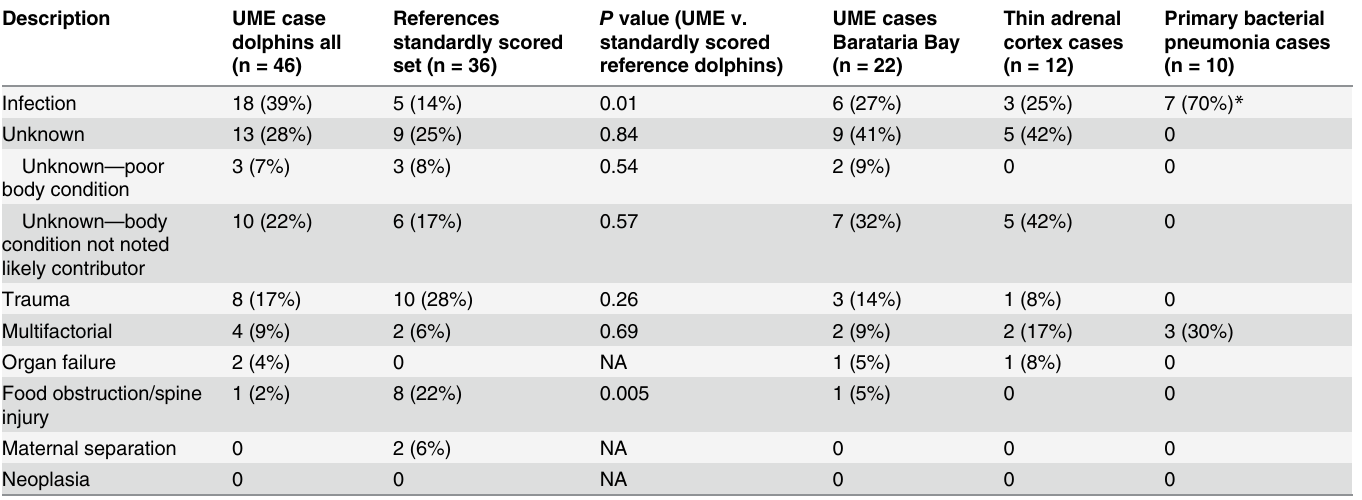
Table 4. Prevalence comparisons of causes of death for fresh dead, stranded common bottlenose dolphins ( Tursiops truncatus ) among 1) unusu- al mortality event cases from Louisiana, Mississippi, and Alabama, 2) slide-reviewed and standardly scored reference dolphin subset, 3) Barataria Bay, Louisiana UME dolphin subset, and 4) all reference